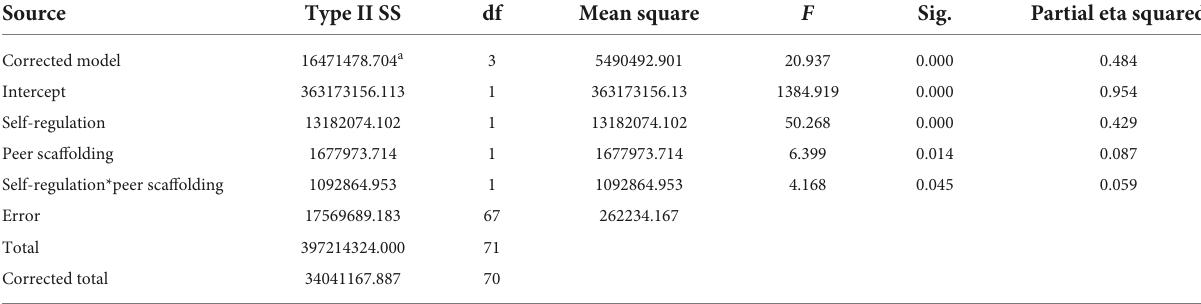
TABLE 5 Factorial ANOVA output: Effects of self-regulation and peer scaffolding on the sum of learned words.